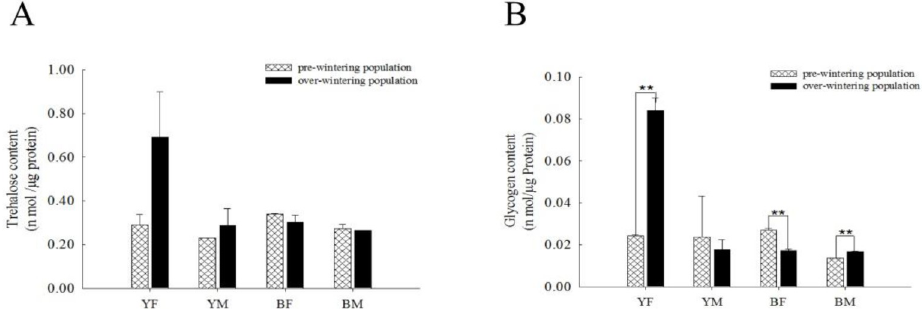
Fig 3. Comparison of changes in trehalose and glycogen content between pre-wintering and over-wintering H . axyridis individuals in females and males of different colour forms. (A) Changes in trehalose content, and (B) changes in glycogen content in pre-wintering and over-wintering yellow females (YF), yellow males (YM), black females (BF) and black males (BM). Each bar depicts the mean (+ SD) of three samples. Trehalose and glycogen content at the pre-wintering stage was used as a control. Asterisks show significant differences between pre-wintering and over-wintering individuals in the same group (Tukey’s test, �� P < 0.01; � P < 0.05).